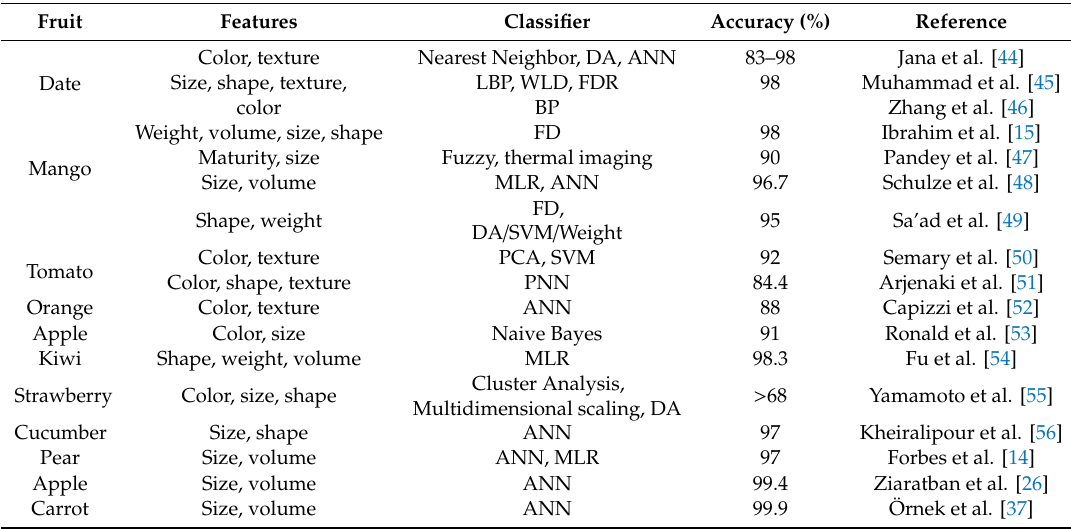
Table A1. Summary of recent grading methods and fruit